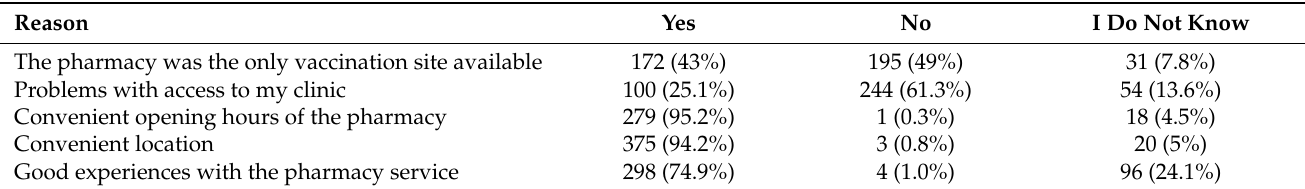
Table 2. The reasons for getting vaccinated against COVID-19 at the pharmacy.